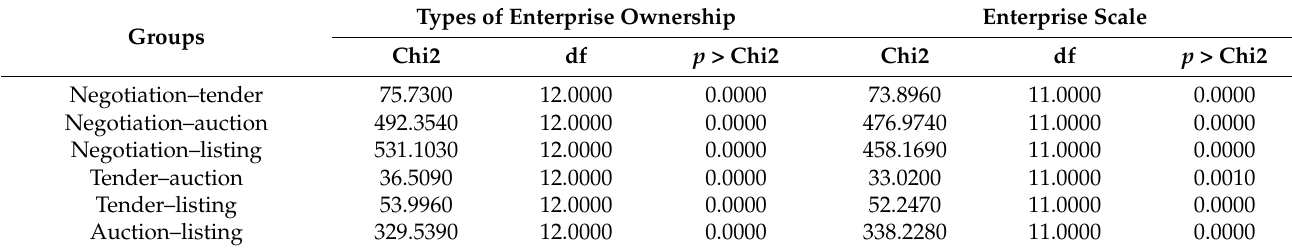
Table 12. Indifference test between groups,